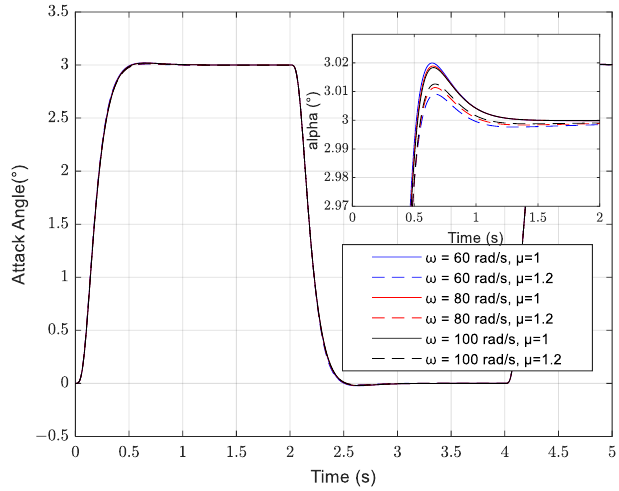
Figure 7. Response of Angle of Attack.